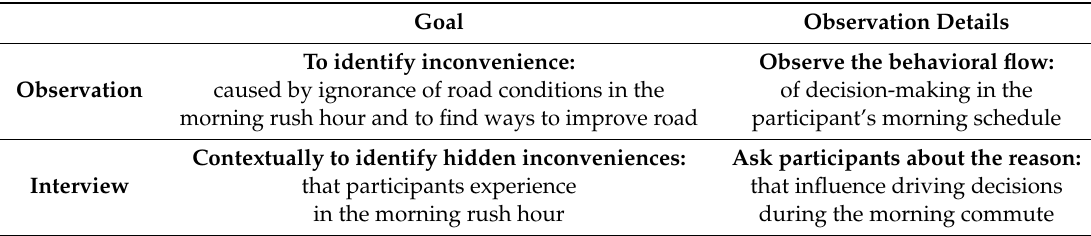
Table 1. User observation research with interview.